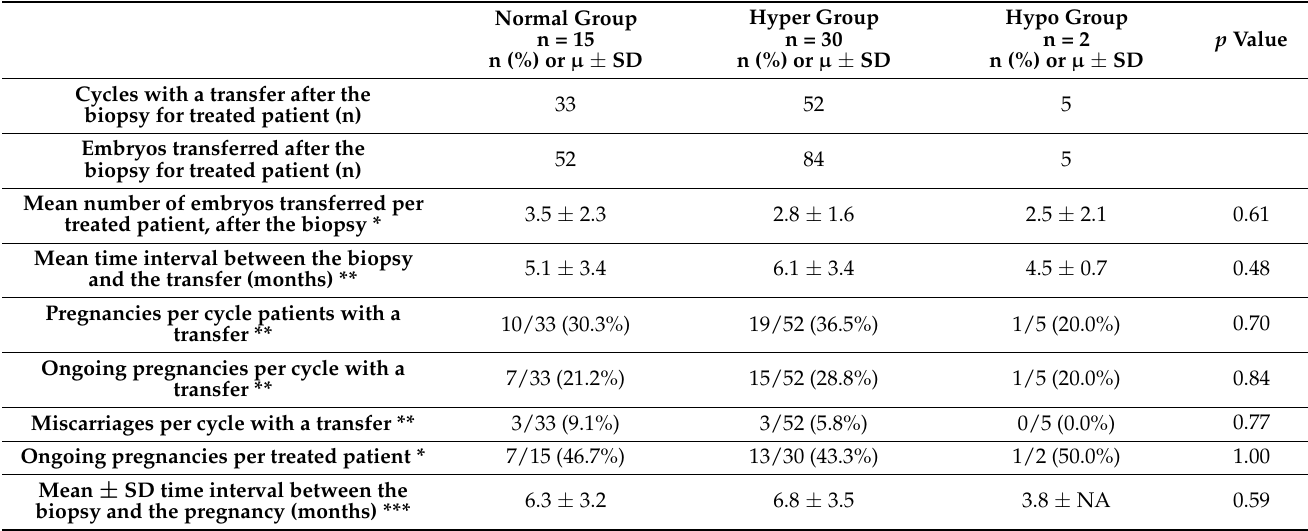
Table 2. Cumulative results for transfer within 12 months for treated